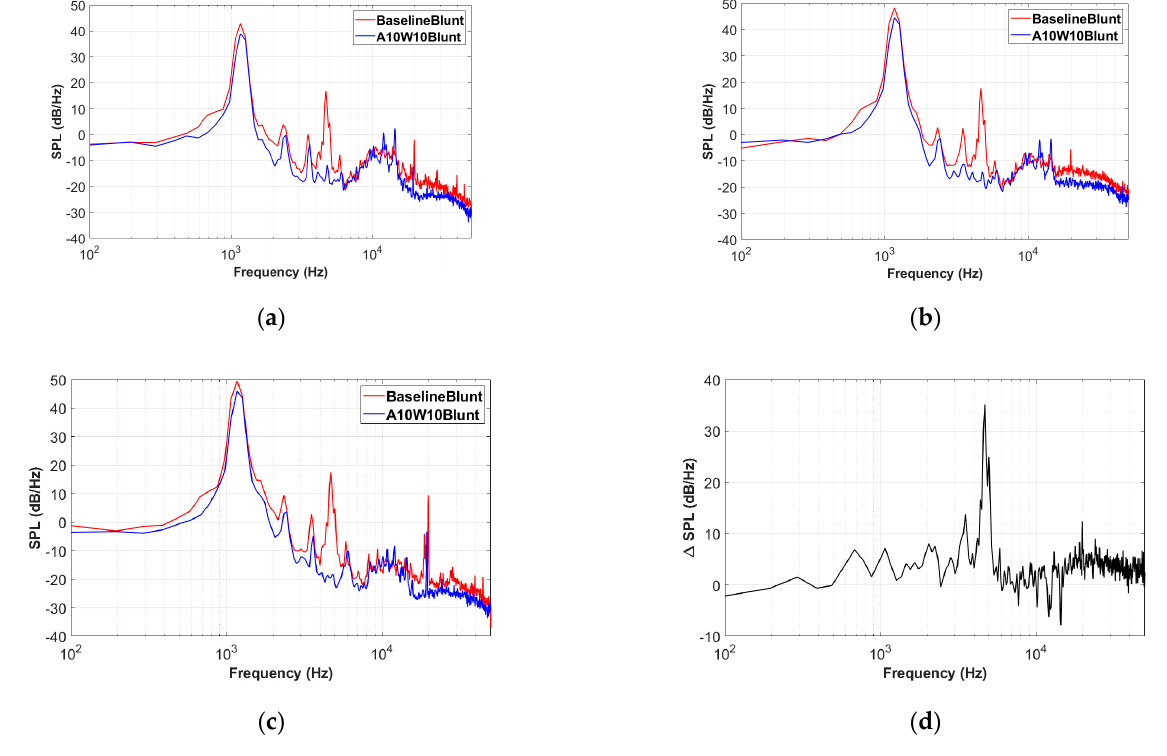
Figure 8. SPL reduction effects of the wavy airfoil: ( a ) SPL at 60 ◦ ; ( b ) SPL at 90 ◦ ; ( c ) SPL at 120 ◦ ; ( d ) ∆ SPL at 90 ◦.